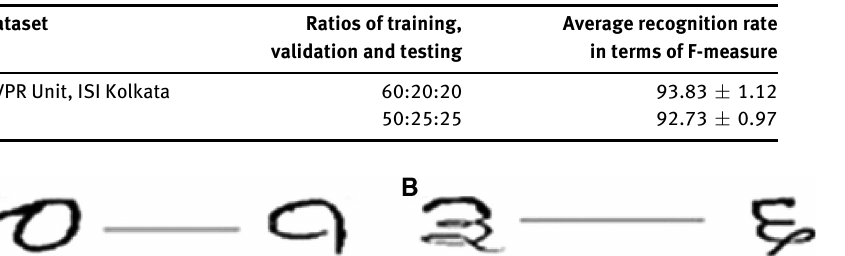
Table 3: Average Recognition Rate.